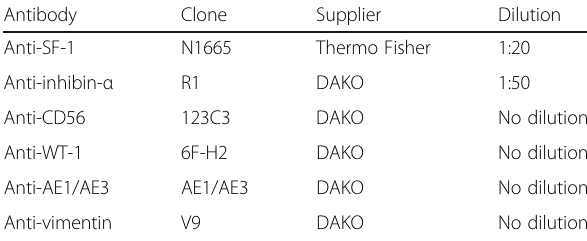
Table 1 List of primary